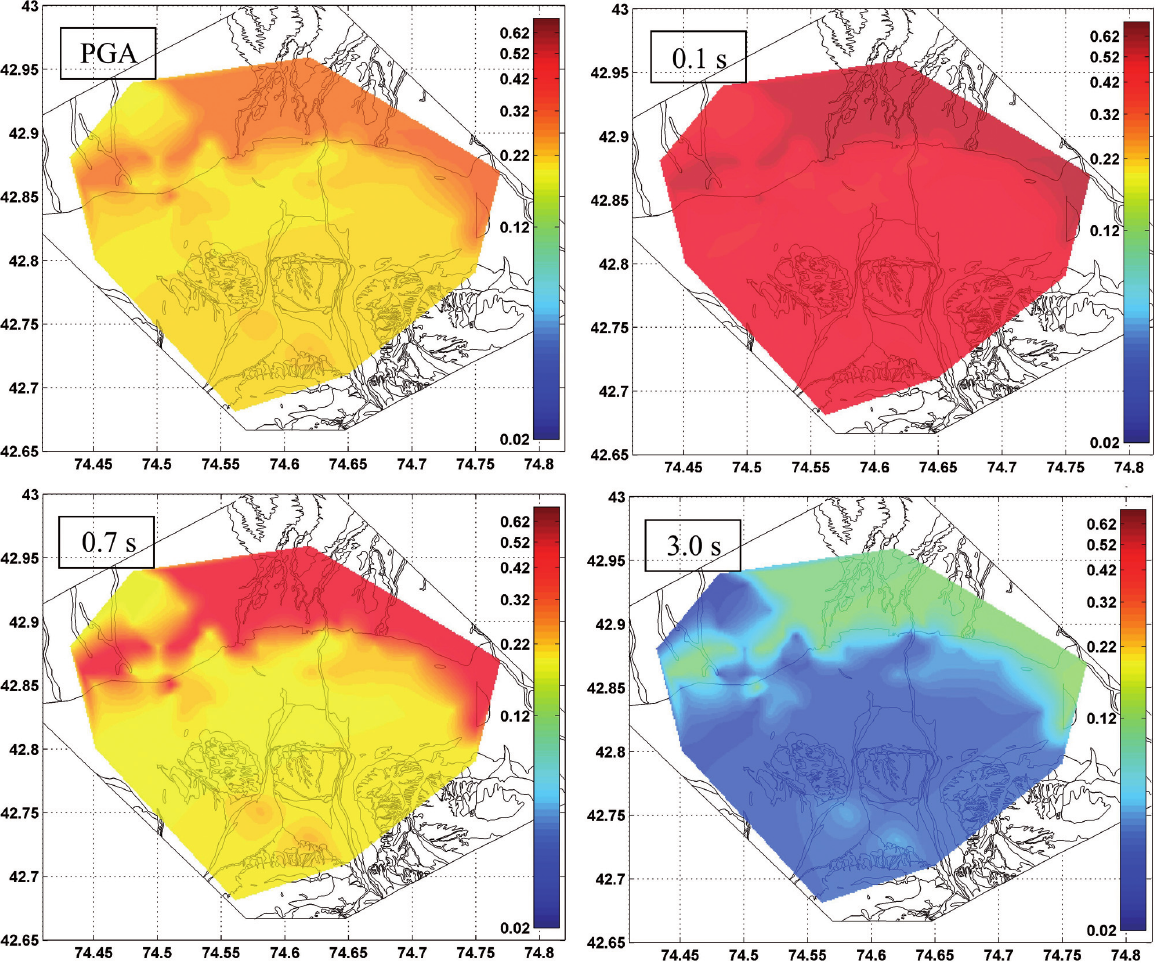
Figure 12. Estimated hazard for 10% probability of exceedance in 50 years considering the distribution of Vs30 values. The level of hazard is shown for PGA and spectral acceleration at different selected periods in terms of g.